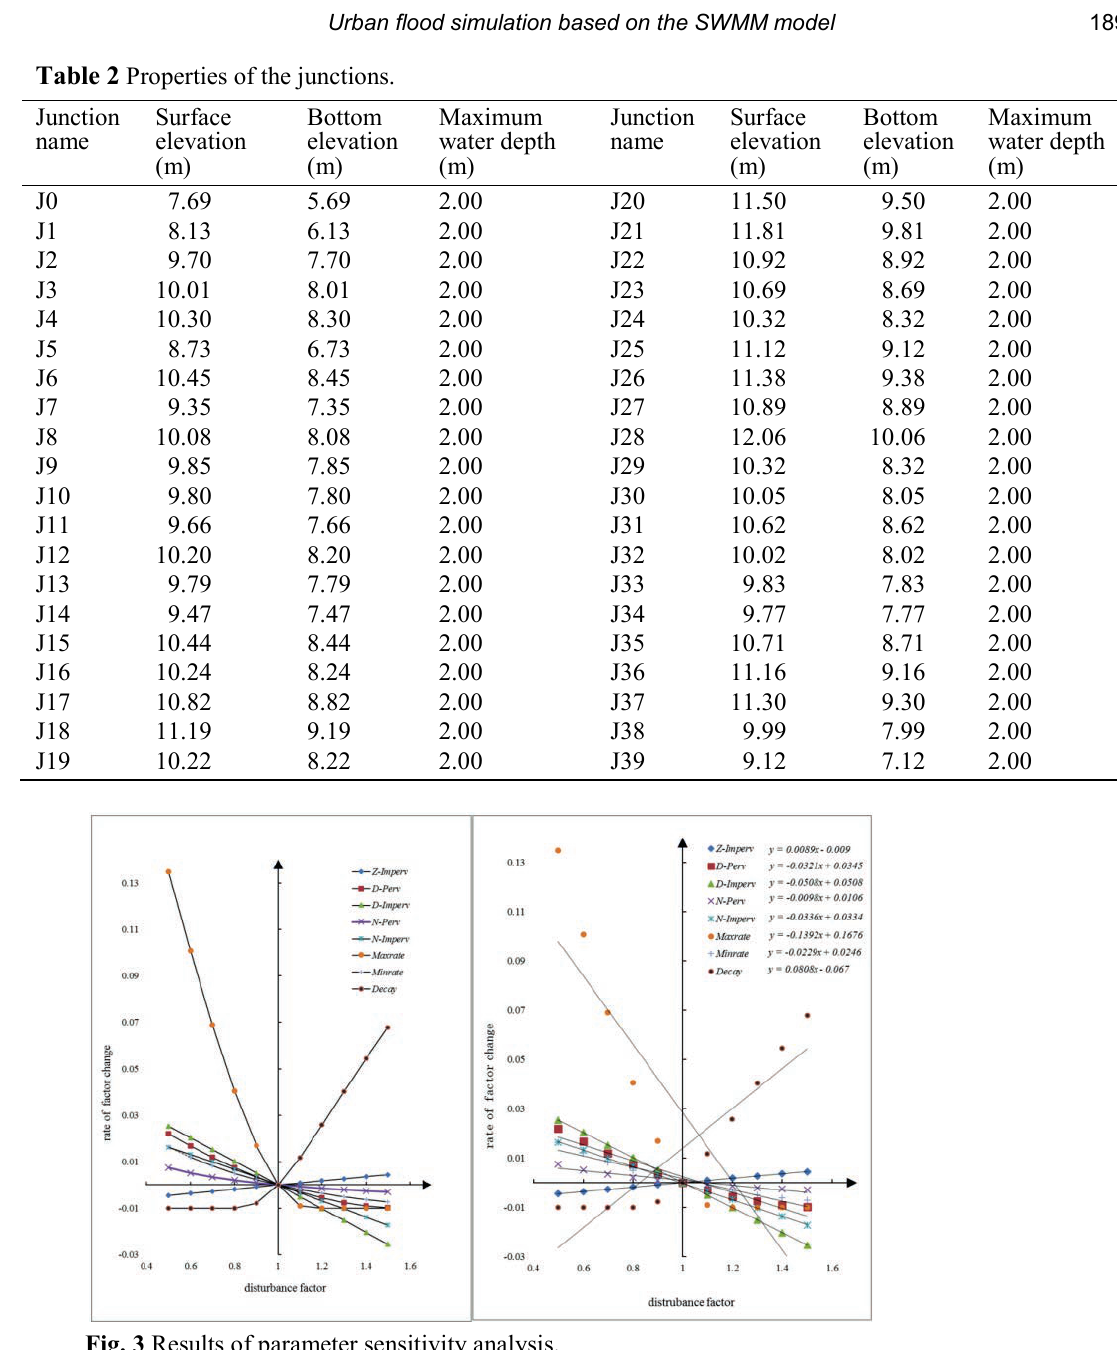
Fig. 3 Results of parameter sensitivity